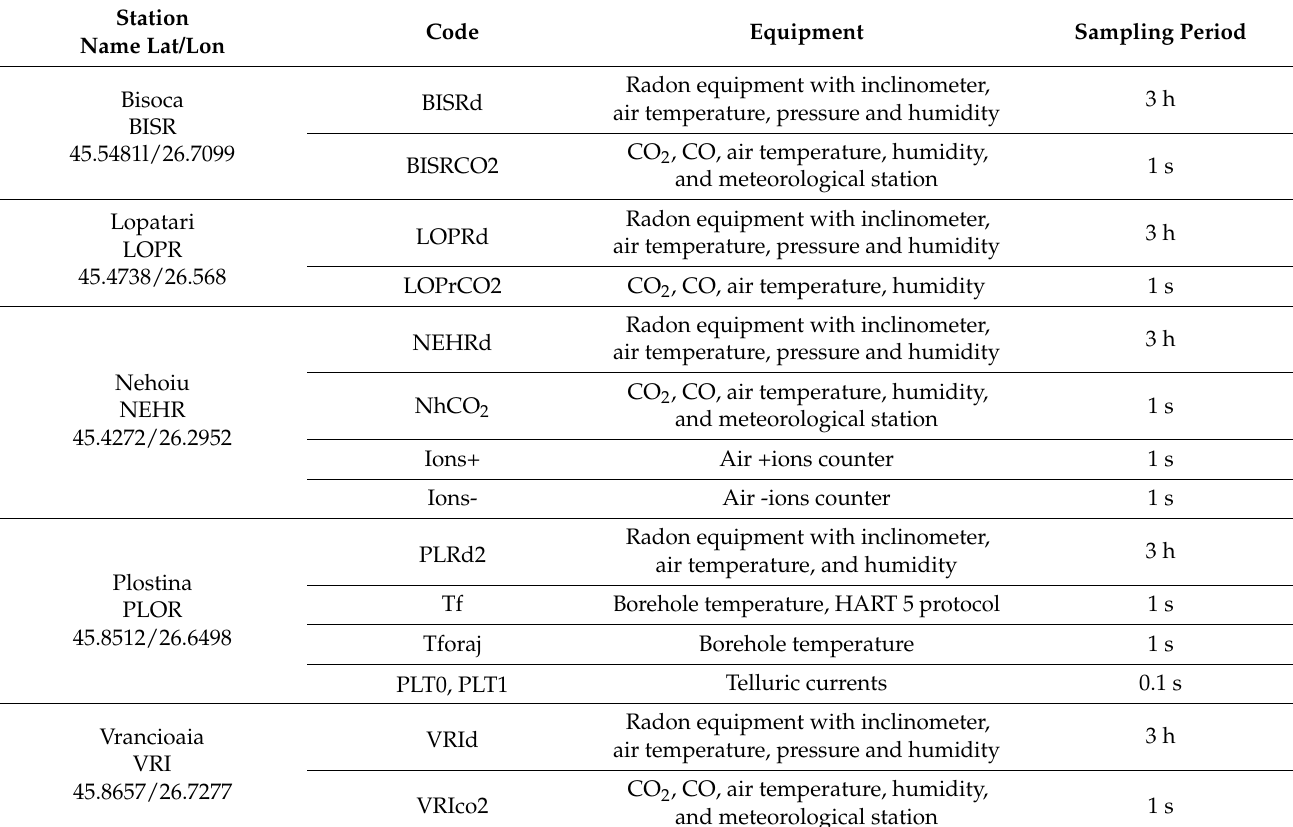
Figure 1. Romania and Vrancea seismicity 2014–2020, gas monitoring network. Table 1 details the monitoring structure. Each location has a unique identification code that allows access to data on the http://geobs.infp.ro/platform. Table 1. Monitoring stations and their